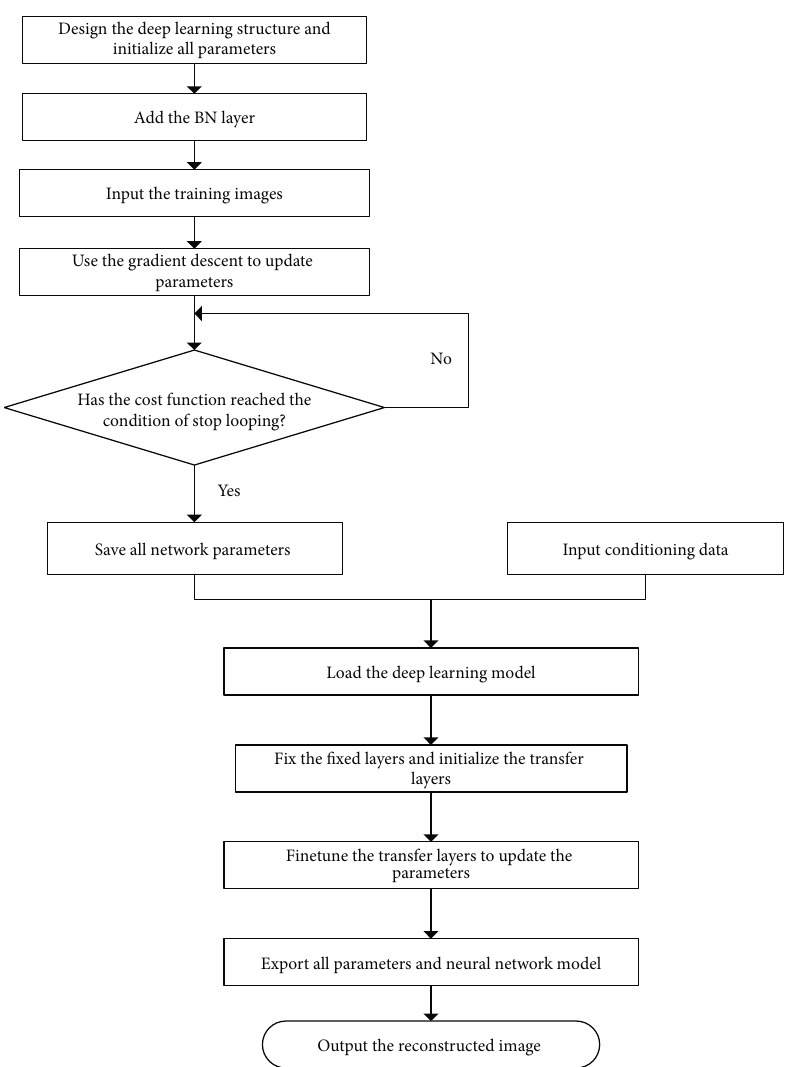
Figure 5: The procedures of the proposed